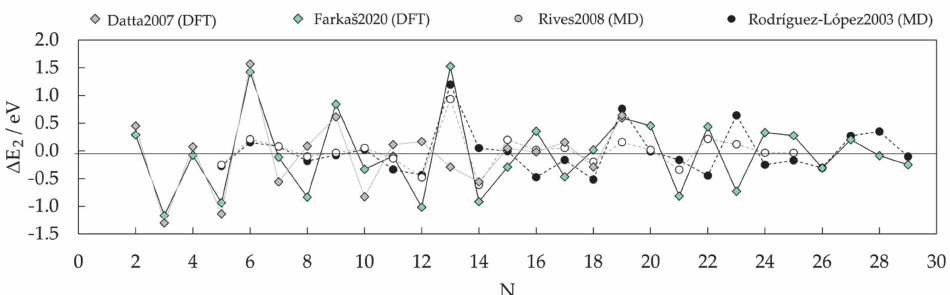
Figure 4. Relative energy stability of successive Co cluster sizes expressed as a second difference in total energy, ∆ E 2 , as predicted by DFT (Datta (2007) and Farkaš (2020) [239,254]) and MD (Rives (2008) and Rodriguez (2003) [252,253])